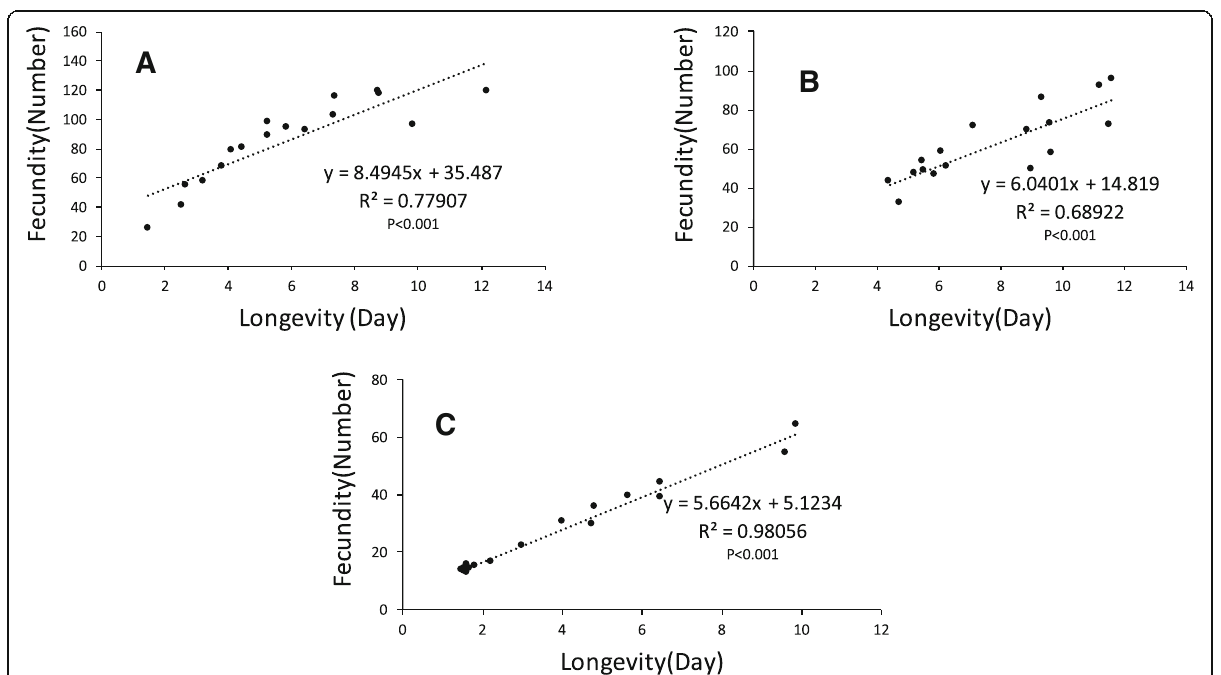
Fig. 3 Relationship between longevity and fecundity of a T. evanescens , b T. bourarachae , and c T.